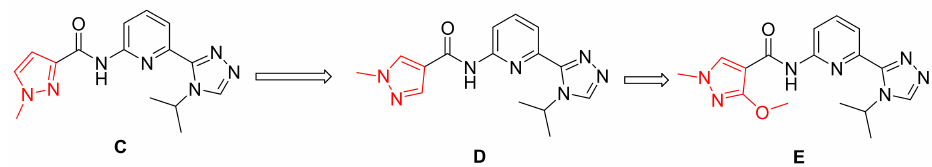
Figure 12. A scheme depicting macrocyclic compound, the lead compound, and a general structure of the target compounds [13].